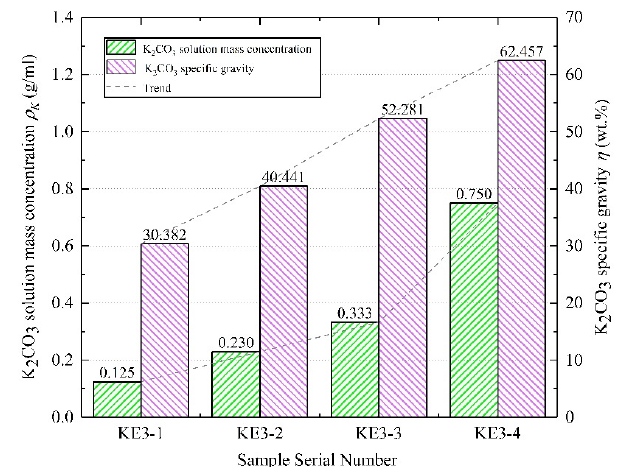
Figure 7. KE3 series samples preparation data.